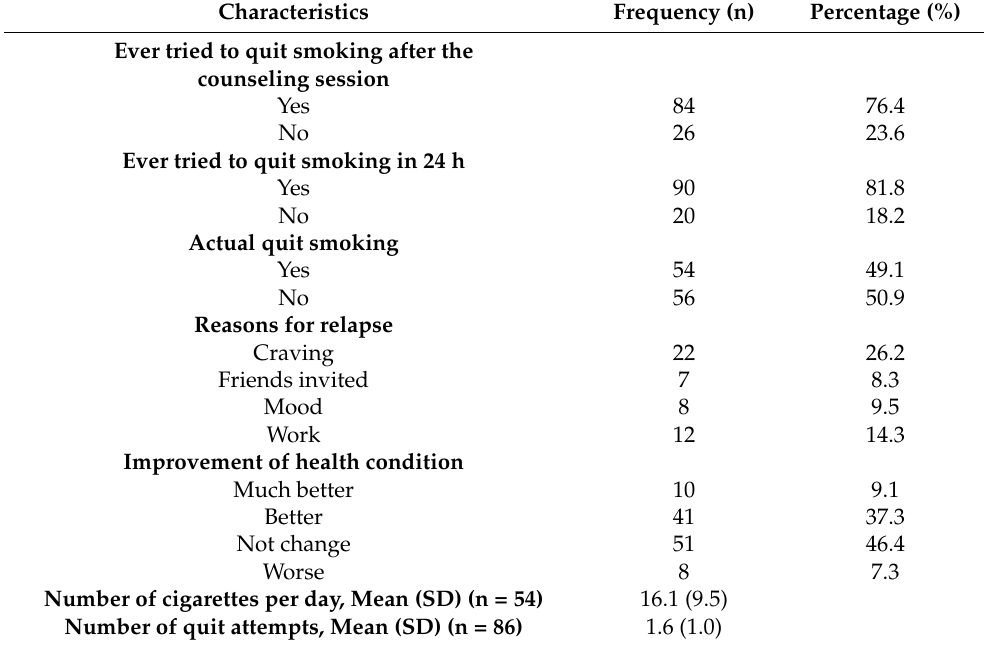
Table 3. Smoking patterns after receiving counseling